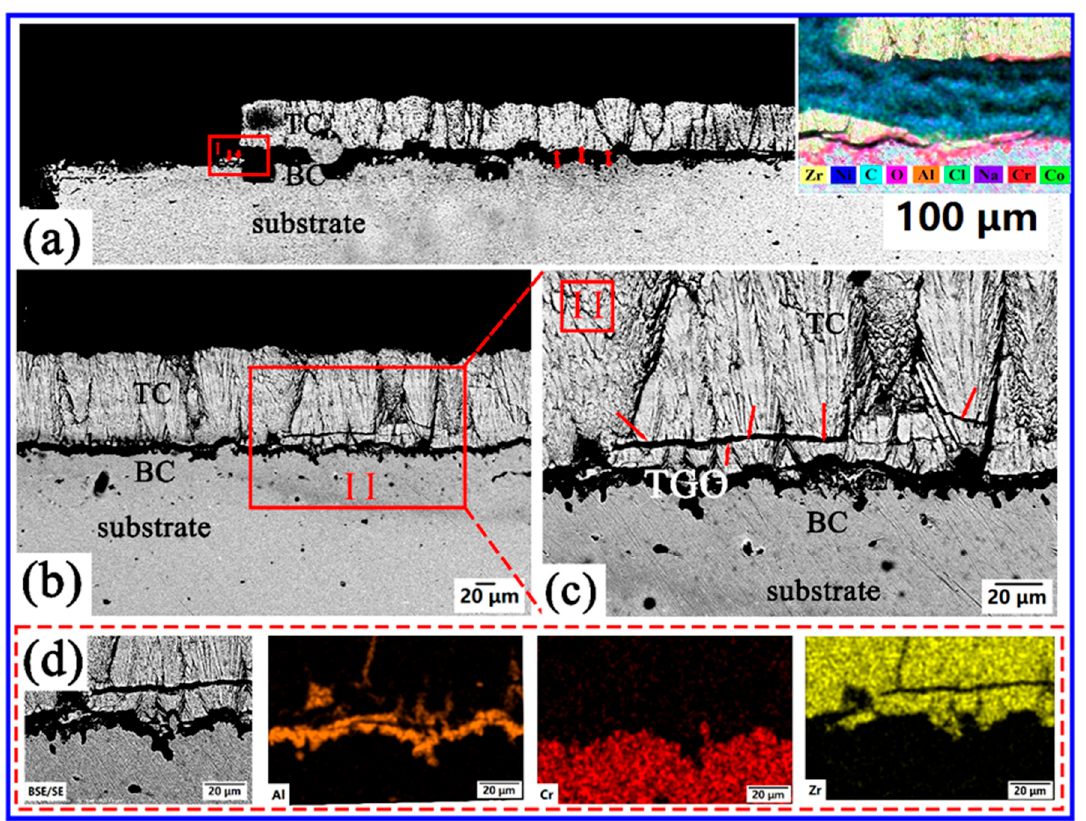
Figure 10. ( a – c ) The cross-sectional morphologies of YSZ coating treated with NaCl from the edge to the center and ( d ) corresponding EDS maps of cracks ( c ).